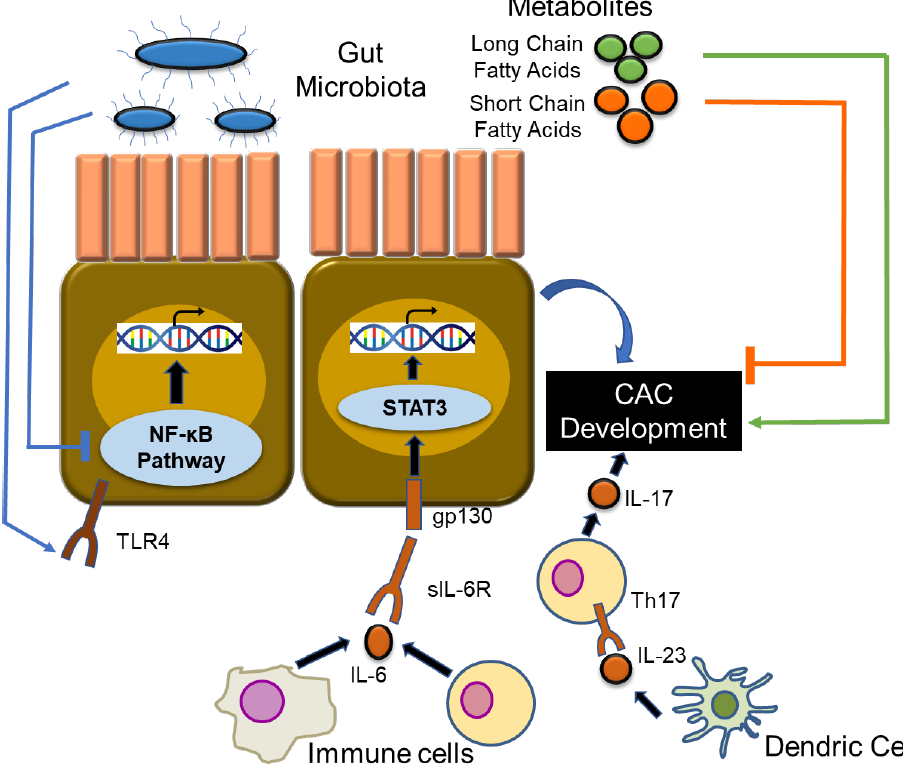
Figure 3. The involvement of cytokine-related signaling pathway, gut microbiome in CAC. This paper has been an overview of CAC carcinogenesis and cytokine-related signaling pathways and the gut microbiome. Various signaling pathways contribute to the development of CAC. Gut microbiota can contribute to both promotion (via activation of toll-like receptors) and suppression of the NF- κ B pathway, depending on the bacterial species. Fatty acid metabolism contributions to CAC are also known. Short-chain fatty acids have a protective role in CAC carcinogenesis. In contrast, long chain fatty acids can lead to cancer development and progression. TLR4: toll-like receptor 4, IL-6R: interleukin-6 receptor.